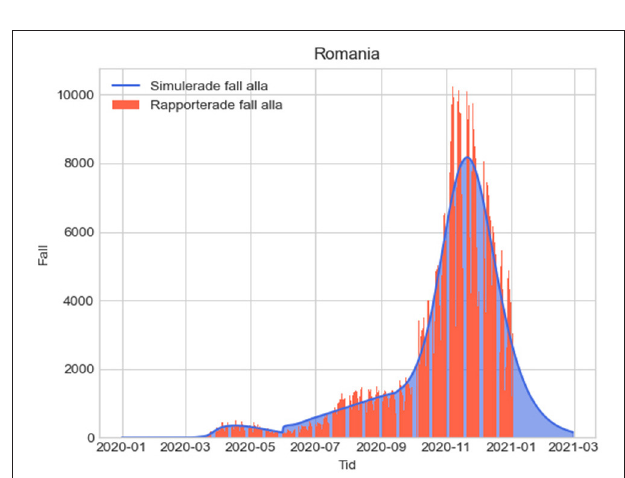
FIGURE 2 | L2: Epidemiologic evolution using the influenza season protocols. Total unreported cases 2020-2021:14,855,222.113; total unreported cases